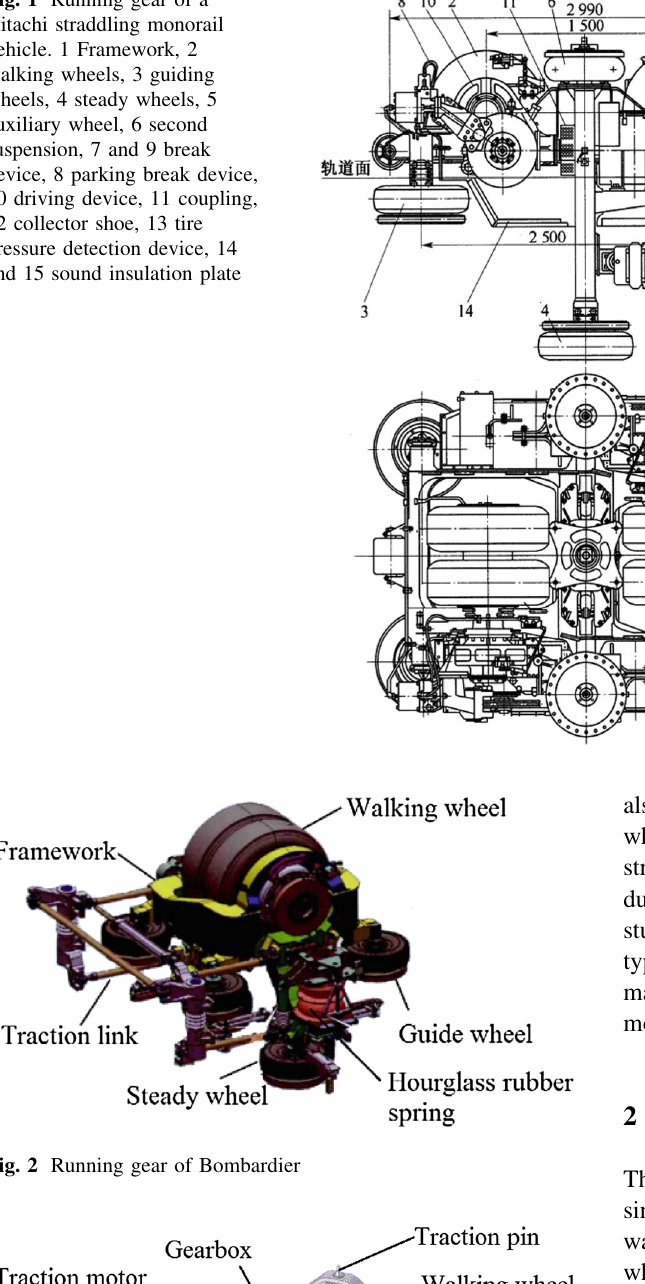
Fig. 1 Running gear of a